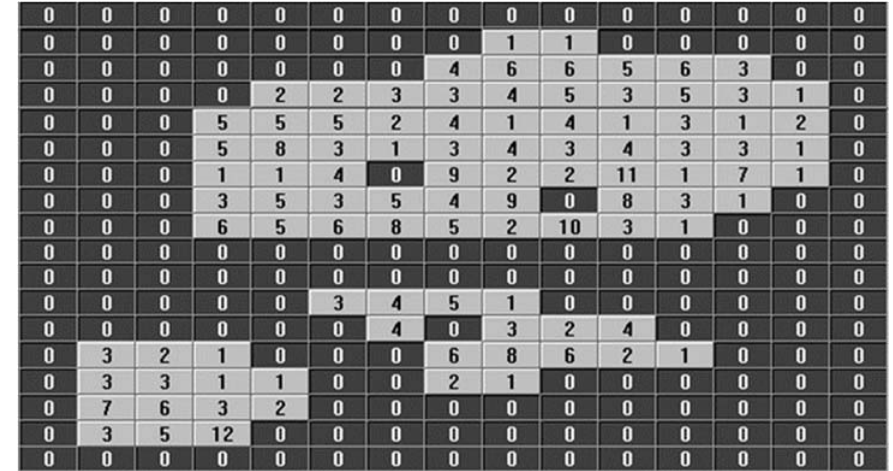
Figure 15. A view of Kohonen’s map as an output of program C ++ .